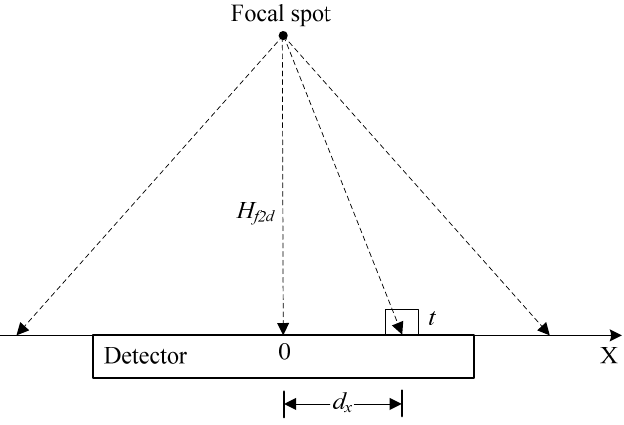
Figure 1. X-ray transmission fan-shaped effect.